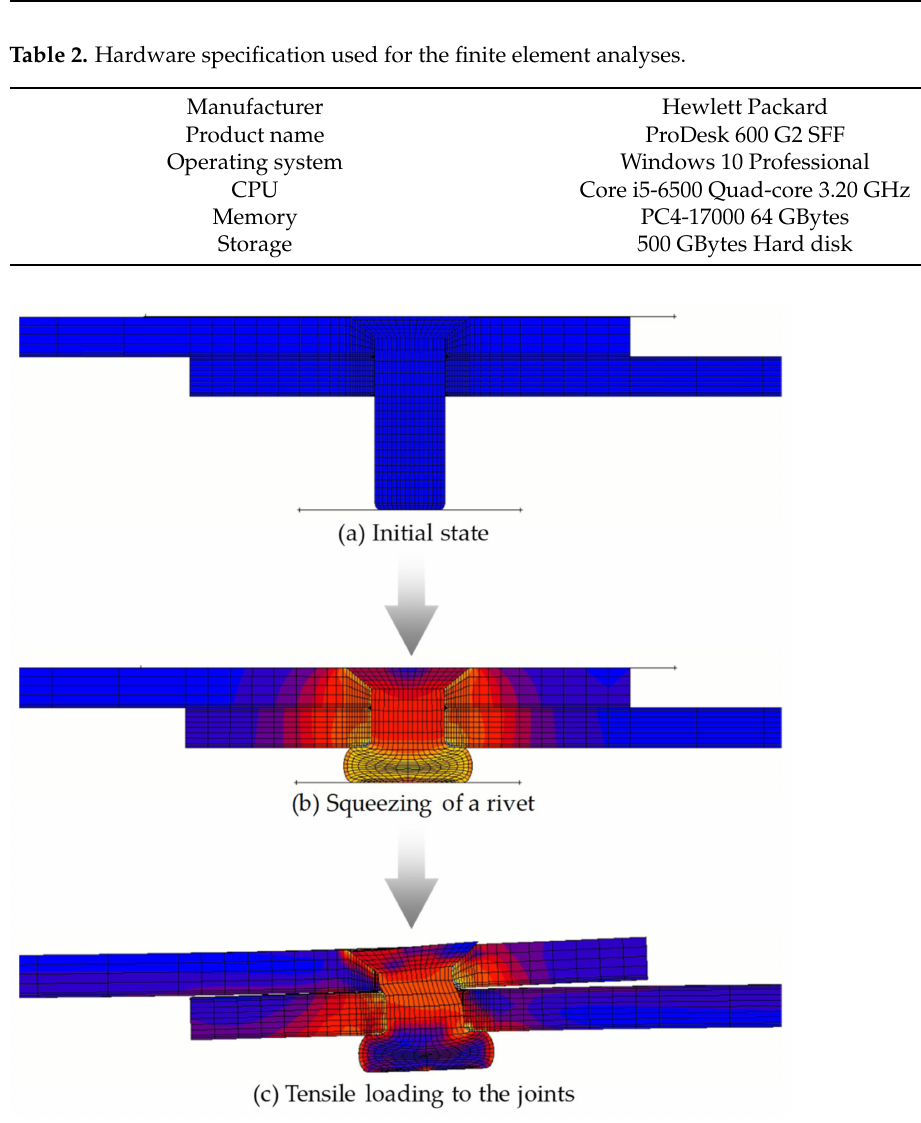
Figure 6. Processes analyzed in the finite element